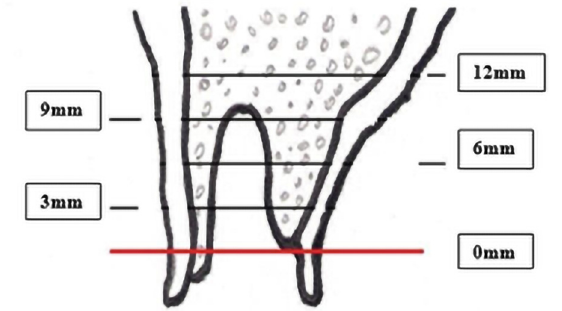
Figure 3. Alveolar transverse width measurement.